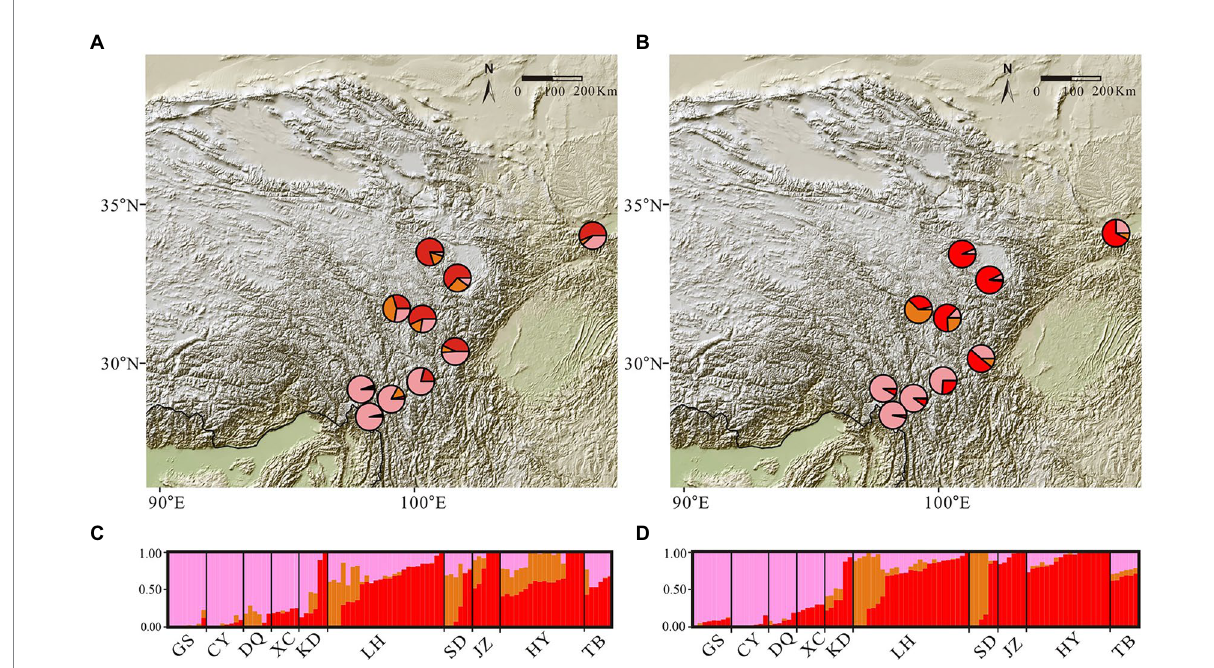
FIGURE 3 Maps of admixture proportions and bar plots for the Gentiana hexaphylla complex inferred using conStruct spatial and non-spatial analyses, using a K-value of three. Pies show mean admixture proportions across individuals from sampling sites inferred using spatial (panel A ) and non-spatial (panel B ) models. Admixture bar plots show genetic clustering in spatial (panel C ) and non-spatial (panel D ) models. Each bar represents an individual. The sampling sites are labelled at the bottom of the bar plots.